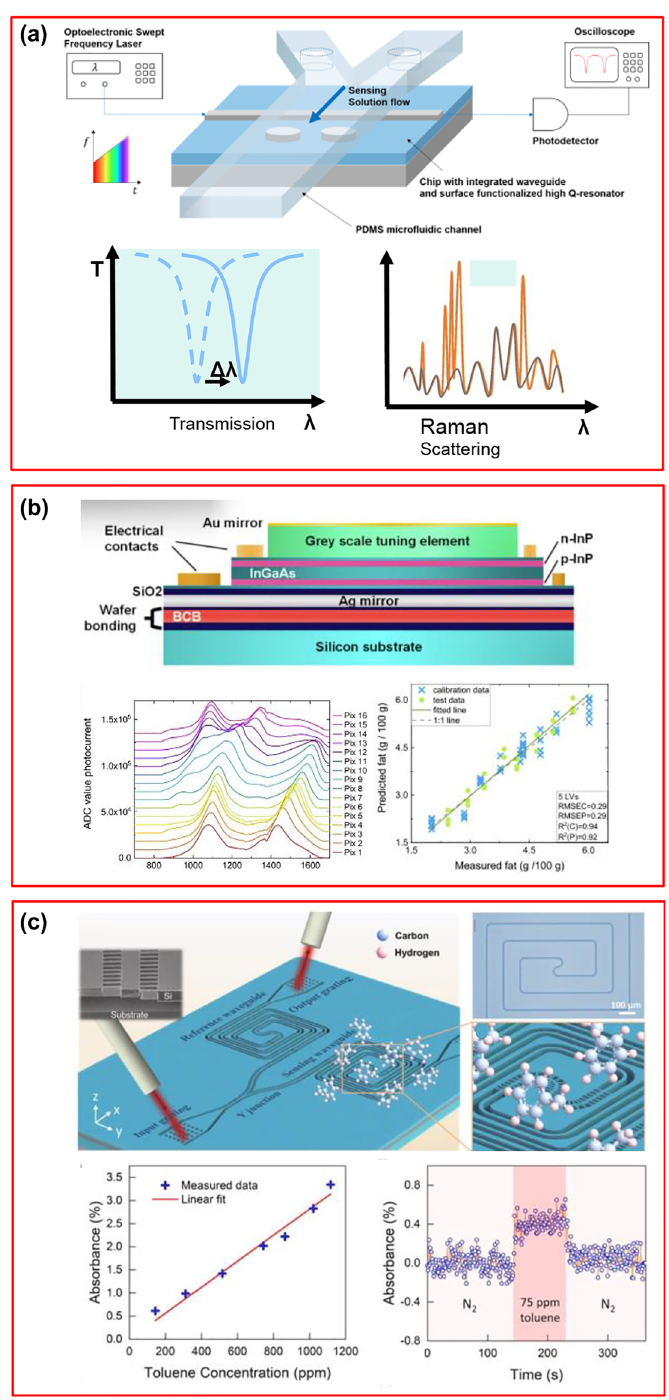
Figure 6: Typical integrated sensing devices. (a) Schematic of bio-sensing using optical micro-resonators [234]. (b) An array of resonant-cavity-enhanced photodetectors suitable for diffuse transmittance/reflectance measurements in the 850 nm–1.7 μ m wavelength ranges on silicon substrate and the use of the multi-pixel array for the measurement of the nutritional properties of milk is presented [227]. (c) Example of mid-IR sensing based on the suspended silicon waveguide platform. Toluene vapor detection is presented with a corresponding limit of detection of 75 ppm. The response and recovery time to 75 ppm toluene are about 0.8 and 3.4 s, respectively [233]. [(a) Reproduced from website [234] http://www.its .caltech.edu/%7Eaphyariv/research.html; (b) reproduced with permission from reference [227]. Copyright © 2018, nature publishing group. (c) Reproduced with permission from reference [233]. Copyright © 2021, De